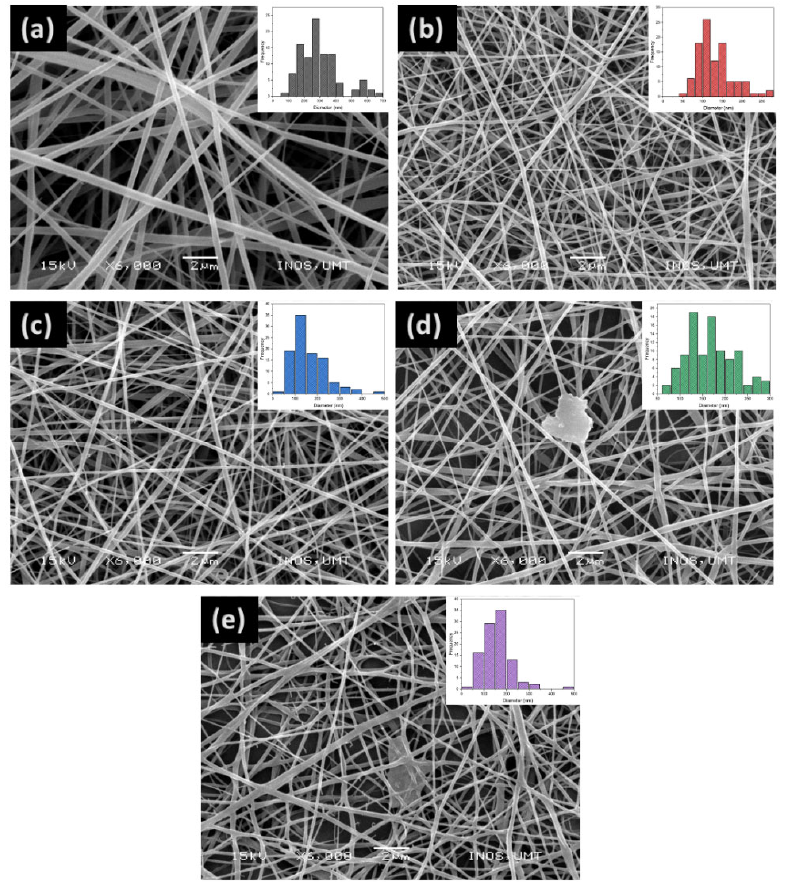
Figure 3. SEM images of electrospun nanofibers from ( a ) PGC, ( b ) PGC-3, ( c ) PGC-5, ( d ) PGC-10 and ( e ) PGC-15 nanofibers at 6000 magnifications. The insets show the fiber diameter distributions. Scale bar: 2 μ m.